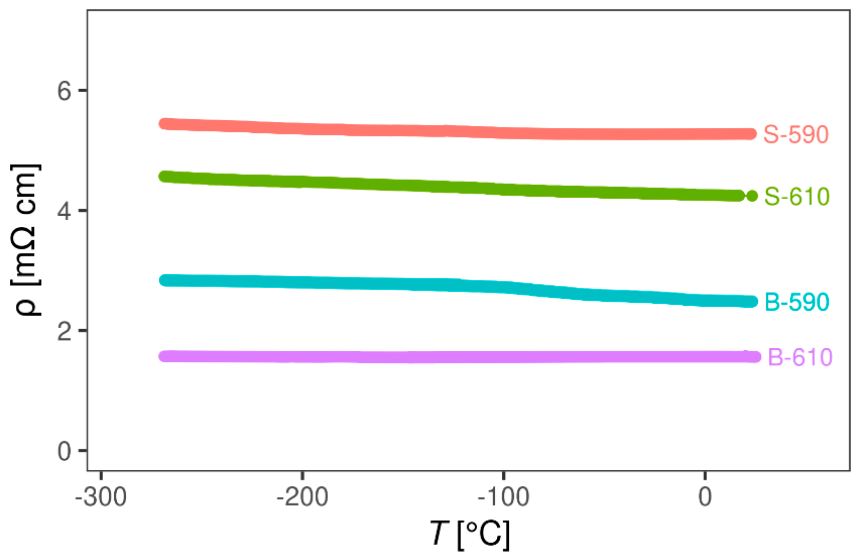
Figure 6. Resistivity of SnO 2 samples as a function of temperature.